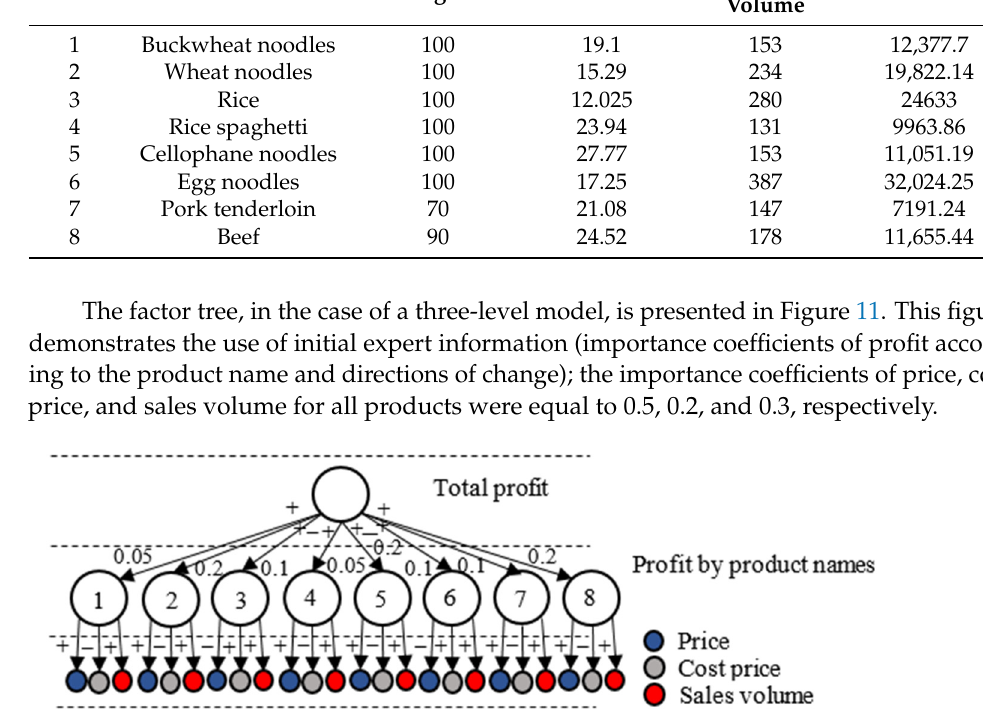
Table 2. Input data.